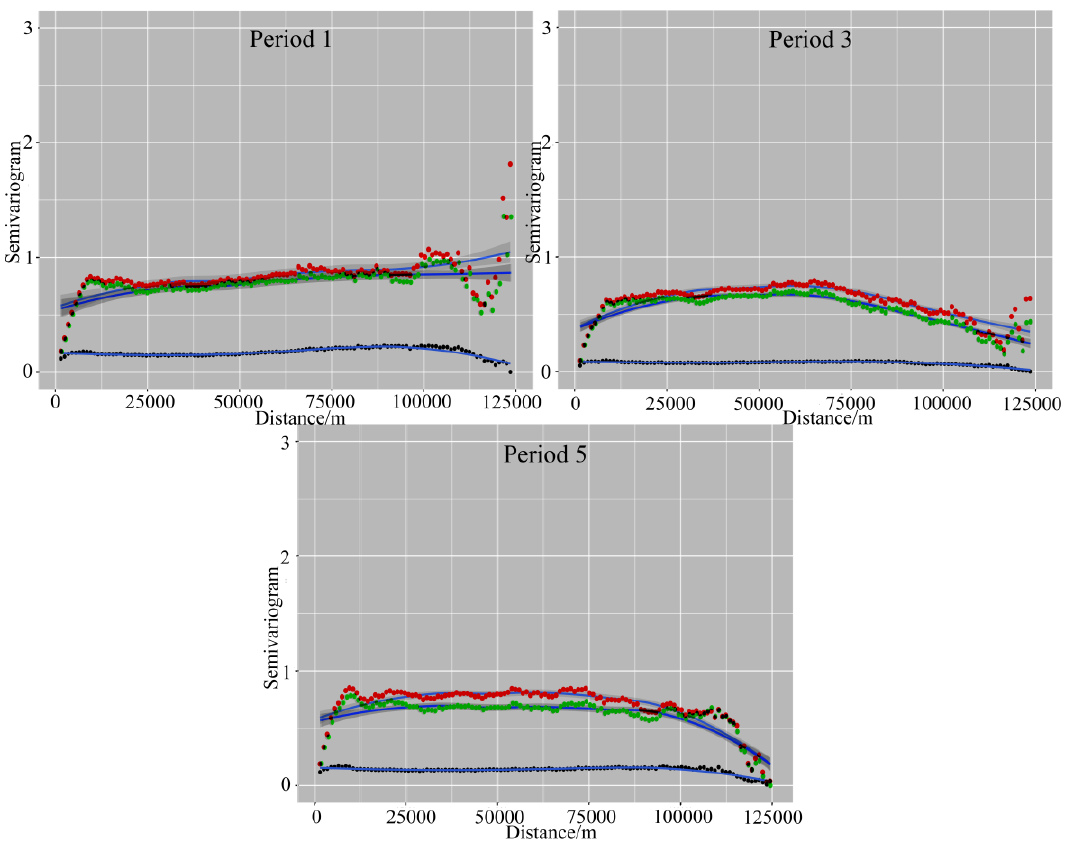
Figure 11. Semivariograms of the three models (LM in red, GWR in green and GTWR in black; the blue curve is the fitting plot).